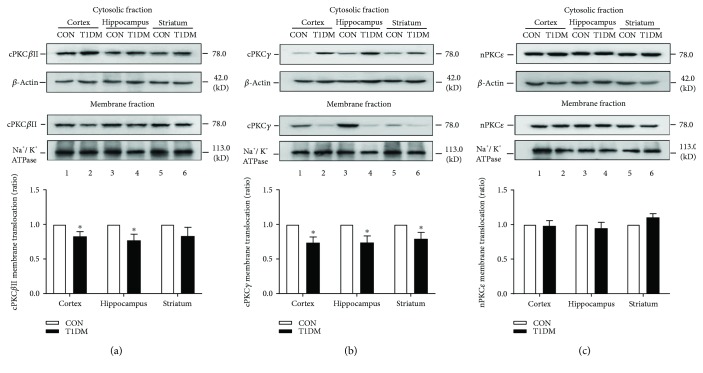
Membrane translocation of PKC isoforms in the cortex, hippocampus, and striatum at 8 weeks after STZ injection. (a) Representative and statistical results of Western blot analysis showed the membrane translocation of cPKCβII in the cortex, hippocampus, and striatum at 8 weeks after STZ injection. (b) Representative and statistical results of Western blot analysis showed the membrane translocation of cPKCγ in the cortex, hippocampus, and striatum at 8 weeks after STZ injection. (c) Representative and statistical results of Western blot analysis showed the membrane translocation of nPKCε in the cortex, hippocampus, and striatum at 8 weeks after STZ injection. ∗p < 0.05 compared with the CON group. n = 6 per group.